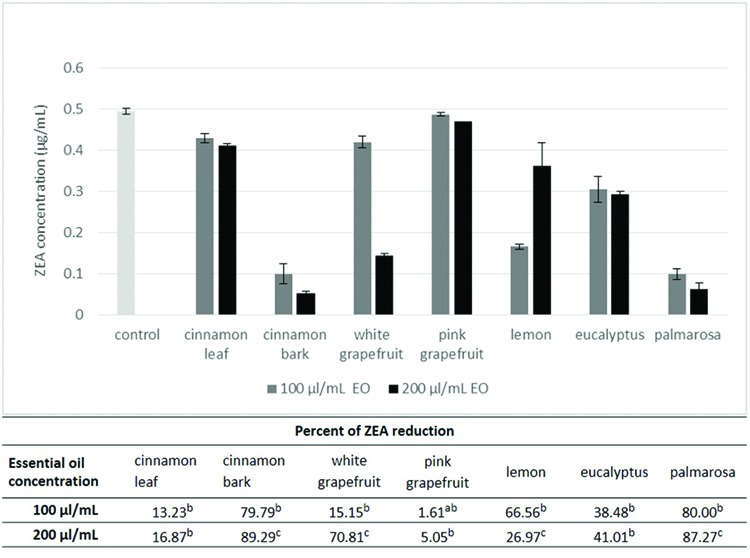
The effect of the essential oils concentration on degradation of zearalenone. The experiment was conducted for 72 h at 20°C. Amount of zearalenone was determined by HPLC method. The concentration of EO was 100 and 200 μl/mL. Data were analyzed by Student’s t-test at p < 0.05 (a, b, c – significantly different in column as well as in relation to control trial).